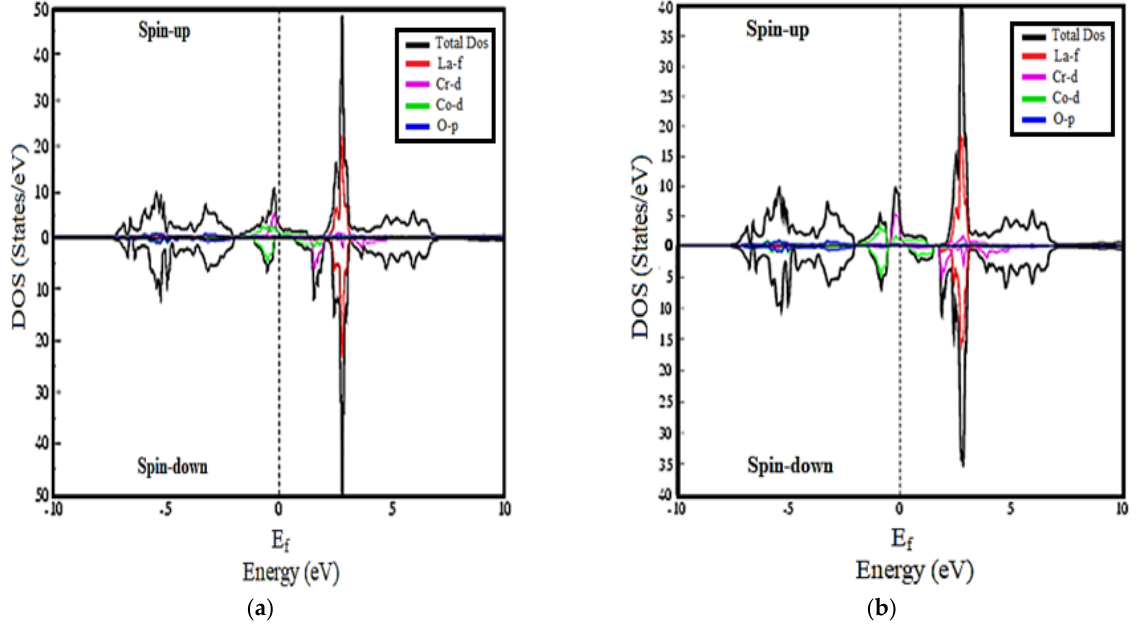
Figure 4. Density of states (DOS) of La 2 CrCoO 6 using ( a ) GGA and ( b ) GGA+U.